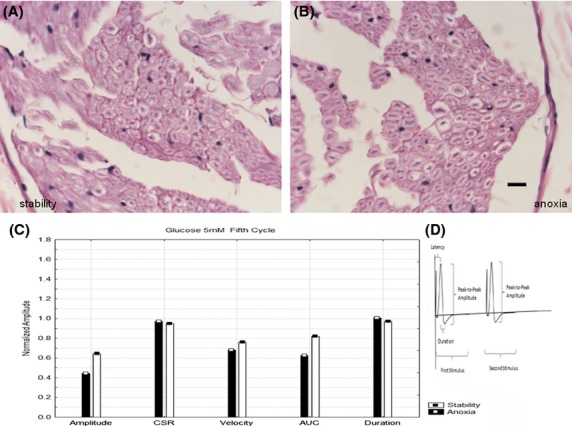
Hematoxylin and eosin stained nerve cross-sections at 60×. (A) Nerve maintained in fully oxygenated state at 37°C throughout the experiment with 5.55 mmol/L glucose showing minimal histological changes. (B) A second nerve maintained at the same temperature and glucose concentration except that it was subject to five cycles of anoxia. There are also minimal histological findings in this case. The line at the bottom of the image represents 10 microns. (C) Neurophysiologic parameters for the nerves whose images are shown above. There is decreased amplitude, area under the curve and velocity after anoxia. There is also a slight increase in duration after anoxia. CSR refers to the ratio of NAP amplitudes in a paired pulse paradigm and AUC refers to the area under the curve. (D) Illustrative example of a recorded nerve action potential and some of the measurements made.